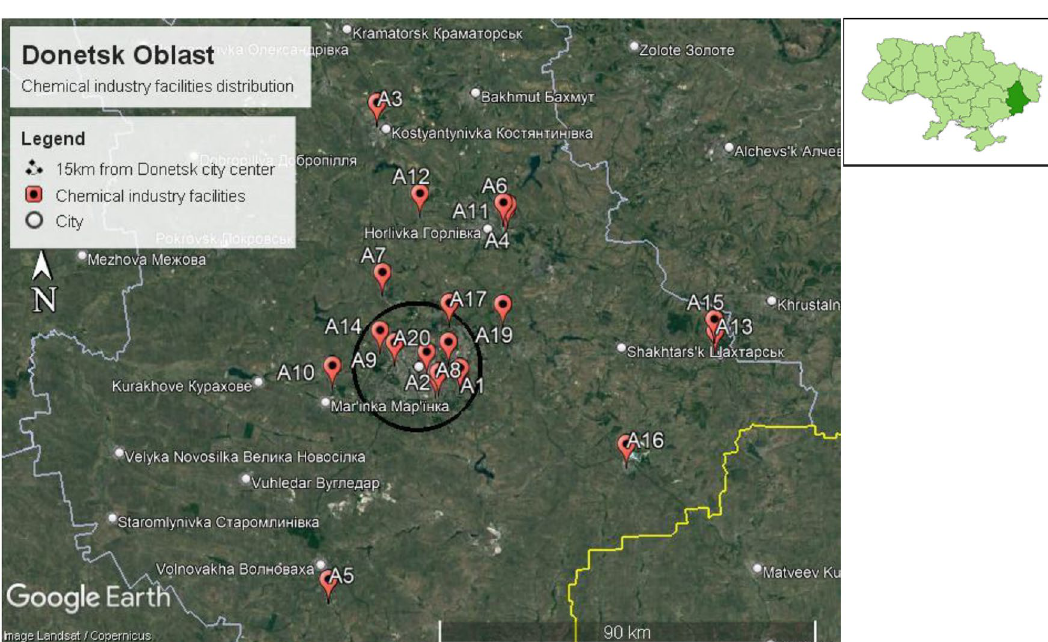
Figure 7. Chemical factories identified within 15 km radius from Donetsk city